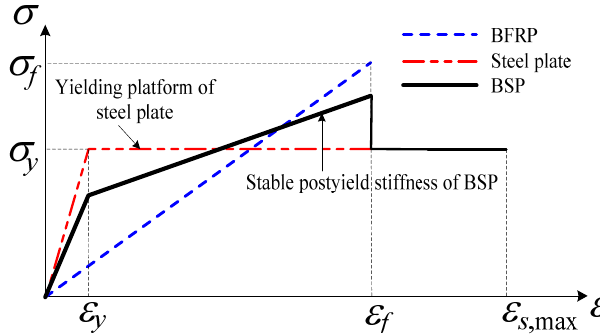
Figure 1. Stress-strain relationship of the basalt fiber-reinforced polymer (BFRP)-steel composite plate